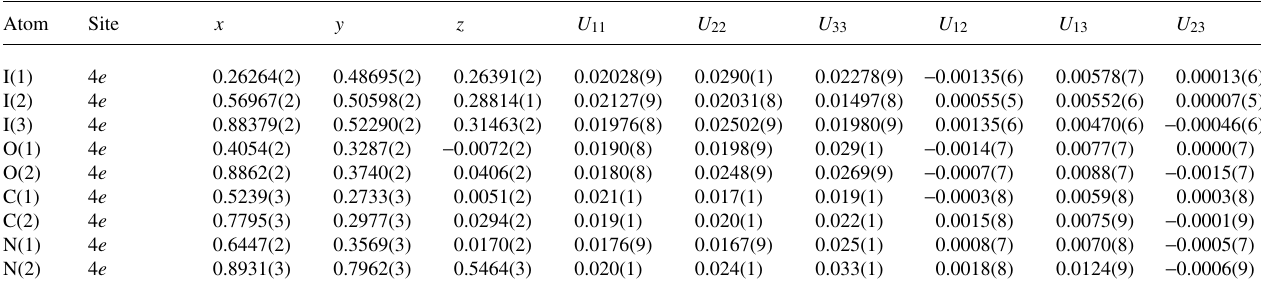
Table 3. Atomic coordinates and displacement parameters (in Å 2 )